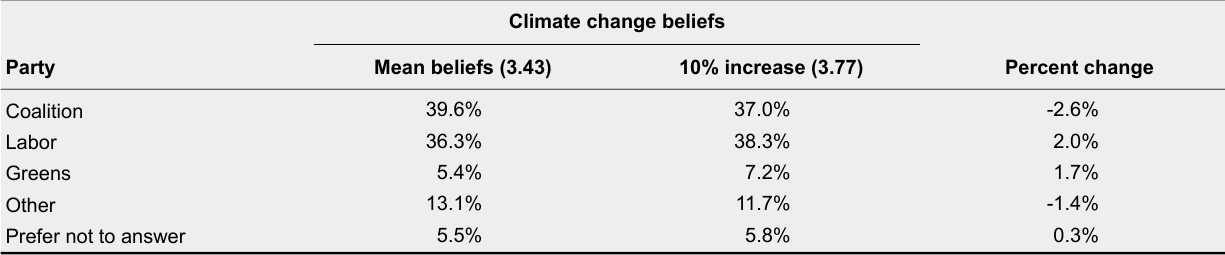
Percent Voting for Different Political Parties Under Two Scenarios: Mean Climate Change Beliefs and a 10% Increase in Climate Change Beliefs changeClimate change beliefs Percent Party 10% increase (3.77)Mean beliefs (3.43) Coalition .6%-2.0%37.6%39 Labor .0%2.3%38.3%36 Greens .7%1.2%7.4%5 Other .4%-1.7%11.1%13 Prefer not to answer .3%0.8%5.5%5 N =